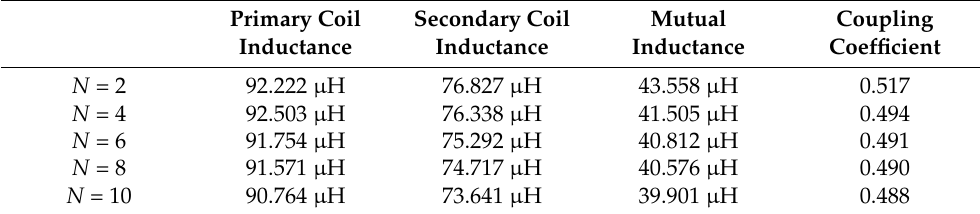
Table 7. Performance comparison for different optimization methods.